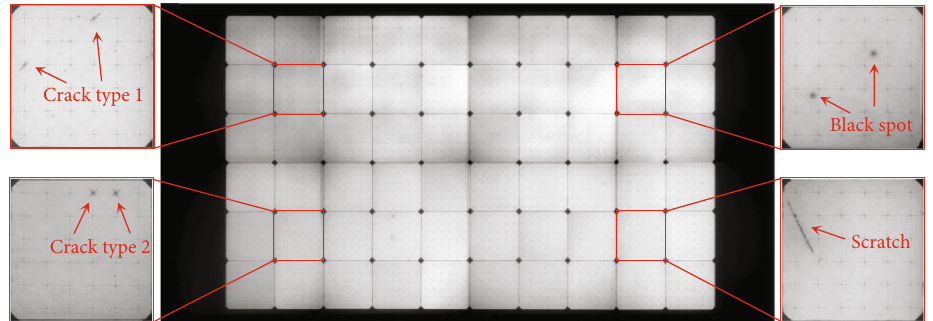
Figure 2: PL image of SCC and partial enlarged view of